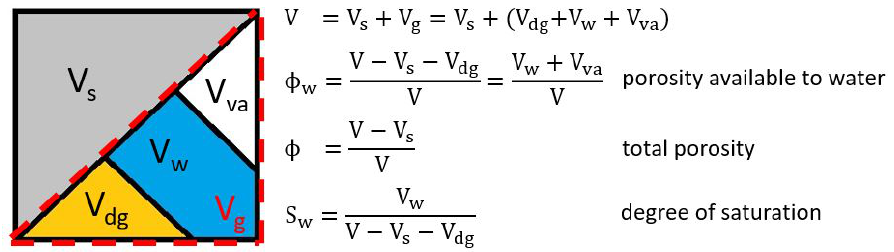
Figure 1. Schematic representation of the assumed bi-phase